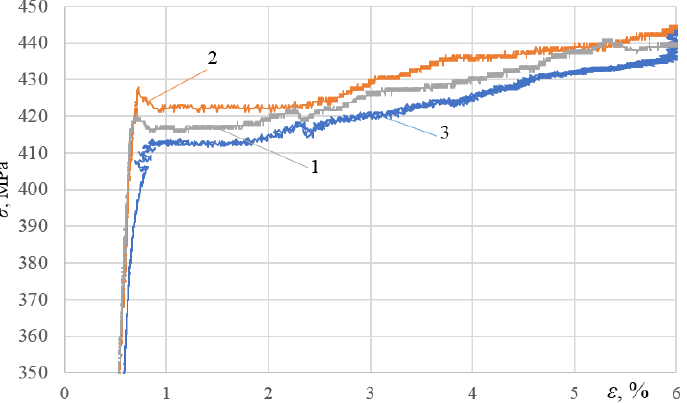
Figure 7. Diagrams of investigated alloys deformation under static tension after DNPs of different intensities: 1—alloy D16ChATW ( ε imp = 5.40%); 2—alloy 2024-T351 ( ε imp = 5.44%); 3—alloy T ( ε imp = 5.37%).